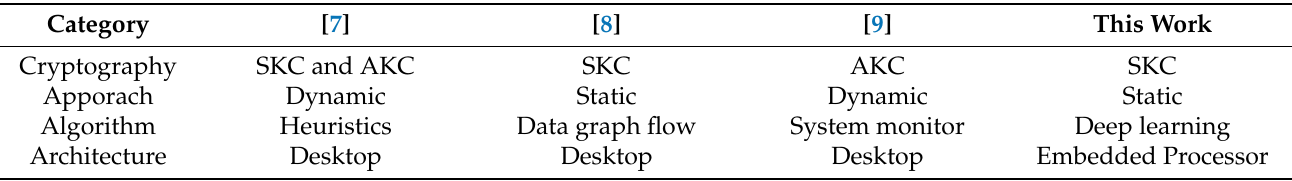
Table 1. Comparison of detection methods based on cryptographic function call. SKC and AKC represent Symmetric Key Cryptography and Asymmetric Key Cryptography,